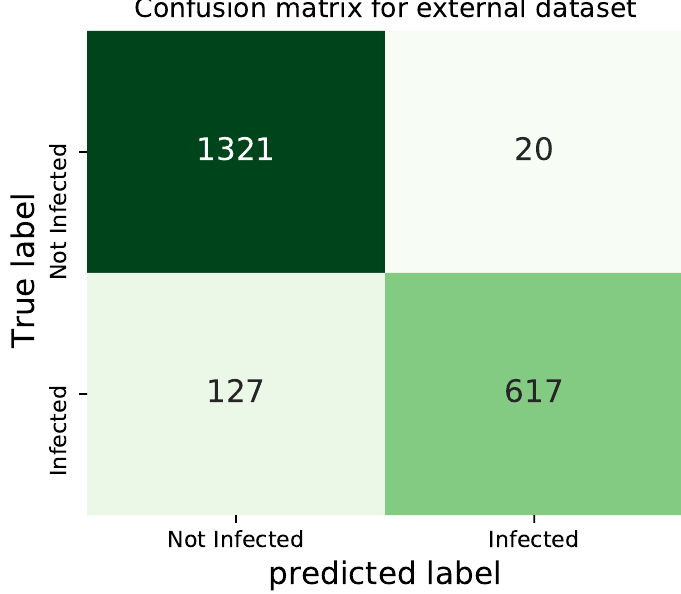
Figure 11. Confusion matrix for the external dataset-1.